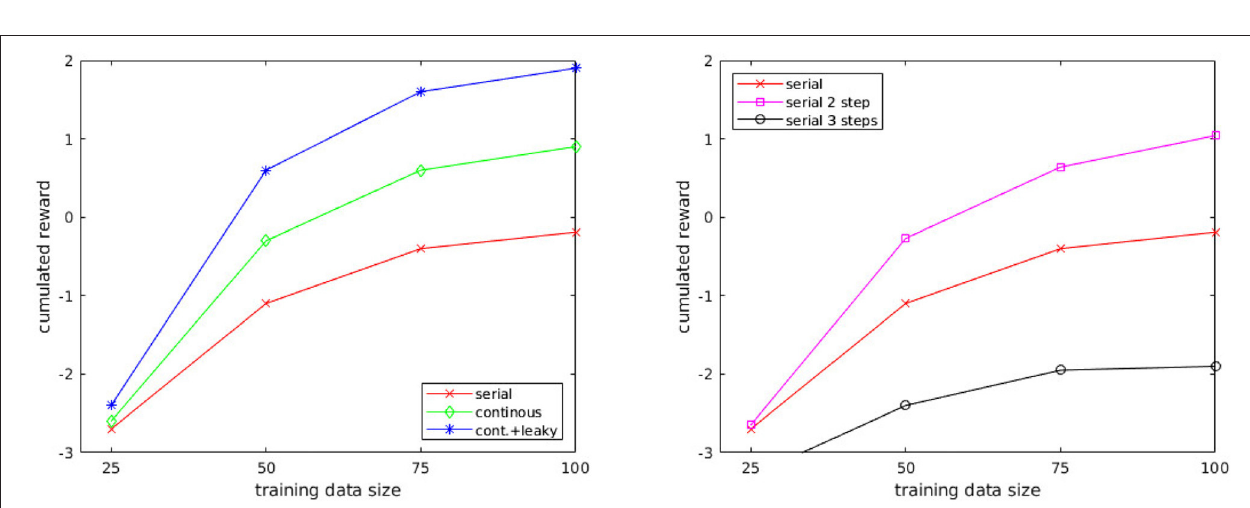
FIGURE 4 | Illustration of the competitive mechanism: global search during the first pass (left), candidates (red) are selected according to a threshold value, and local random search around the candidates during the second pass (right).